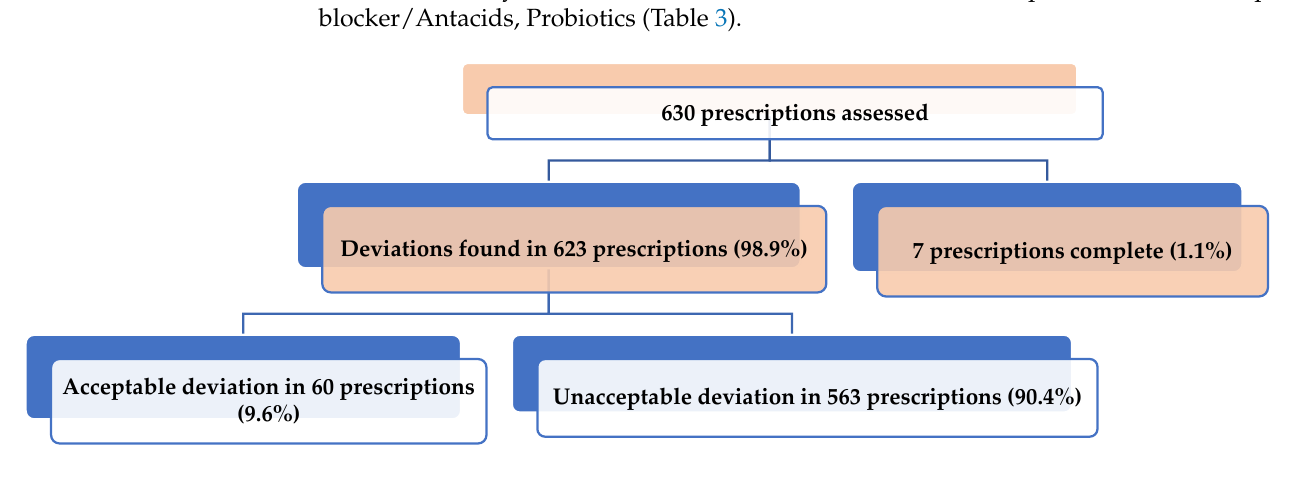
Figure 1. Acceptability of the deviations in assessed prescriptions through a consensus committee ap- proach.